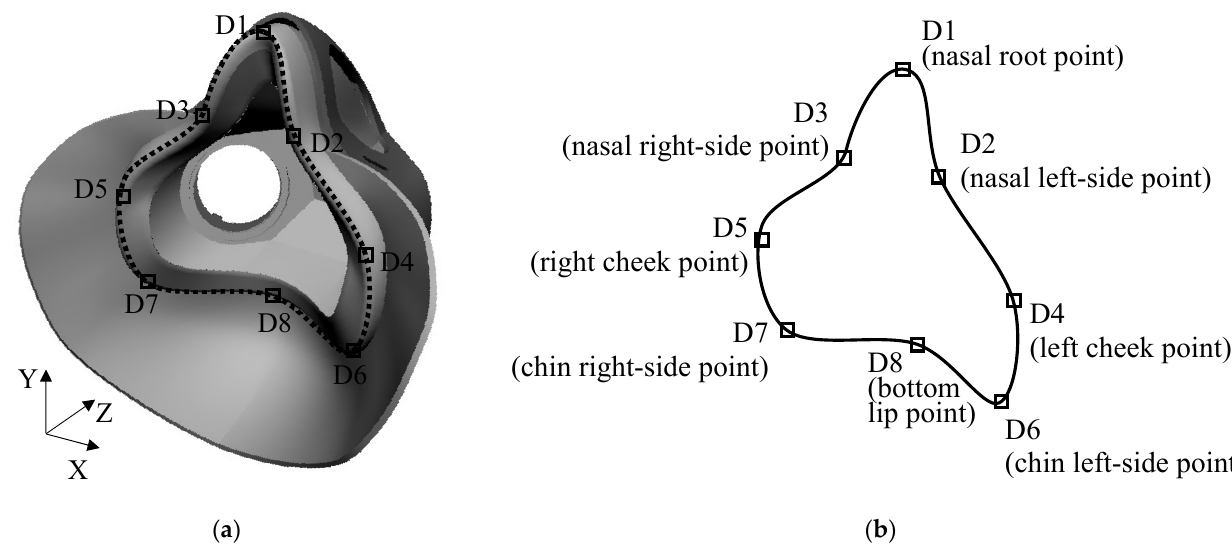
Figure 1. A design of a pilot oxygen mask based on a mask boundary (perspective view): ( a ) design of a pilot oxygen mask; ( b ) a boundary of a mask drawn by a spline curve connecting eight design landmarks.